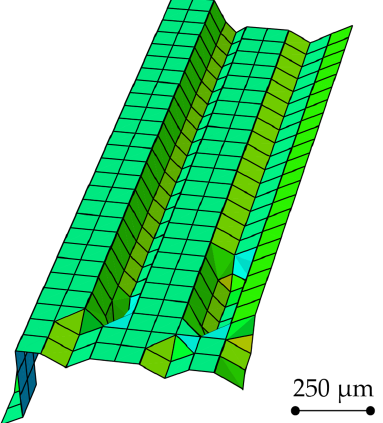
Figure 5. 3D numerical surface profile: peaks and valleys can be observed.